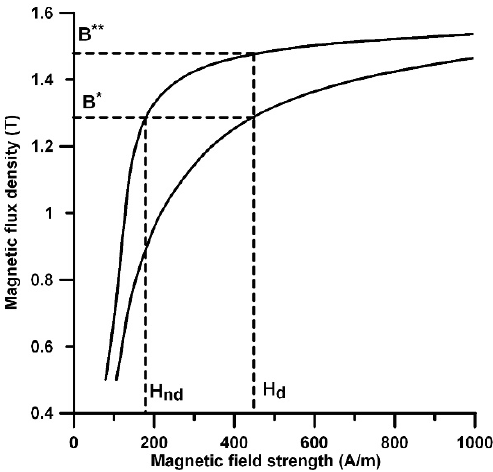
Figure 2. The idea of determining physical quantities B * and B ** flux densities, and H ND and H D magnetic field strengths. The lower B-H curve—for the partially damaged material, the upper B-H curve—for the material without the damaged zone [20].